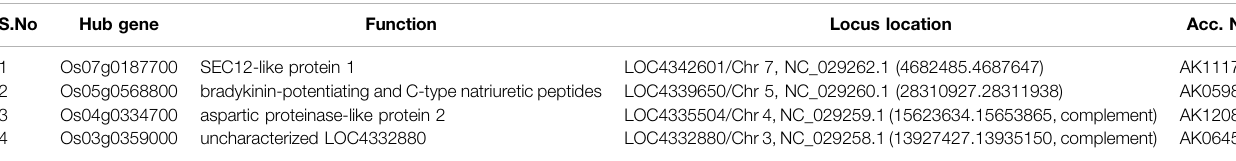
TABLE 8 | Identi fi ed hub genes with respect to their level of connectivity in the pink